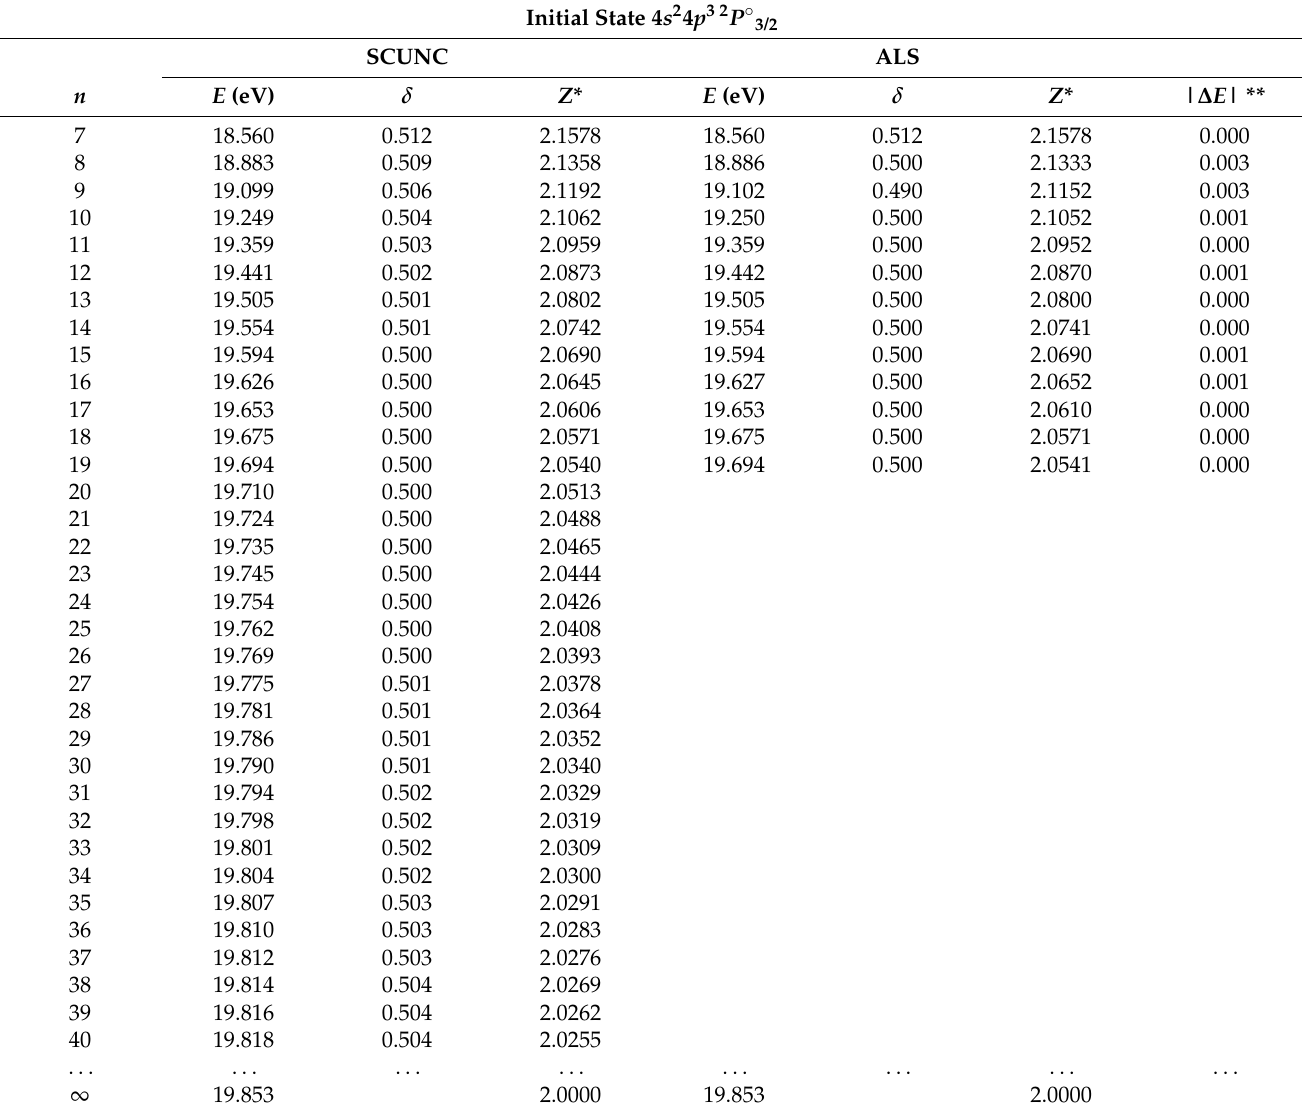
Table 4. Energy resonances ( E ), quantum defect ( δ ) and effective charge ( Z *) of the 4 s 2 4 p 2 ( 1 D 2 ) ns Rydberg series originating from the 4 s 2 4 p 3 2 P ◦ 3/2 metastable state of Se + converging to the 1 D 2 series limit in Se 2+ . The present results (SCUNC) are compared with the experimental data from ALS measurements [6]. The uncertainties in the experimental energies are stated to be ± 0.010 eV, f 1 ( 1 D 2 ; 2 P ◦ − 0.947 ± 0.050 with ν = 3/2 ) =